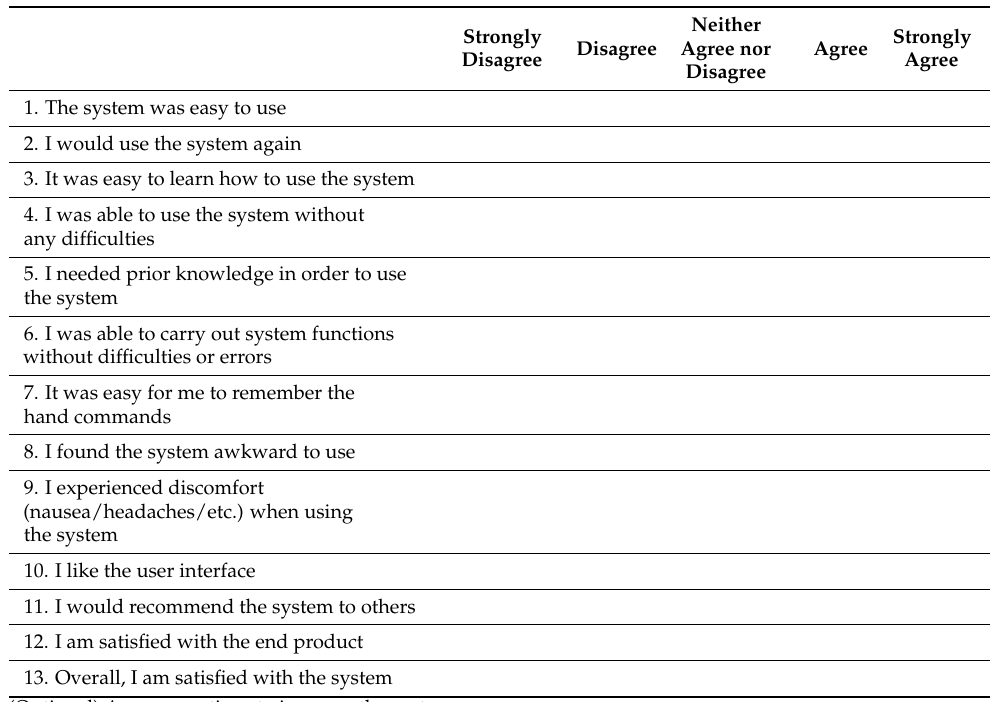
Table A2. Participant Usability